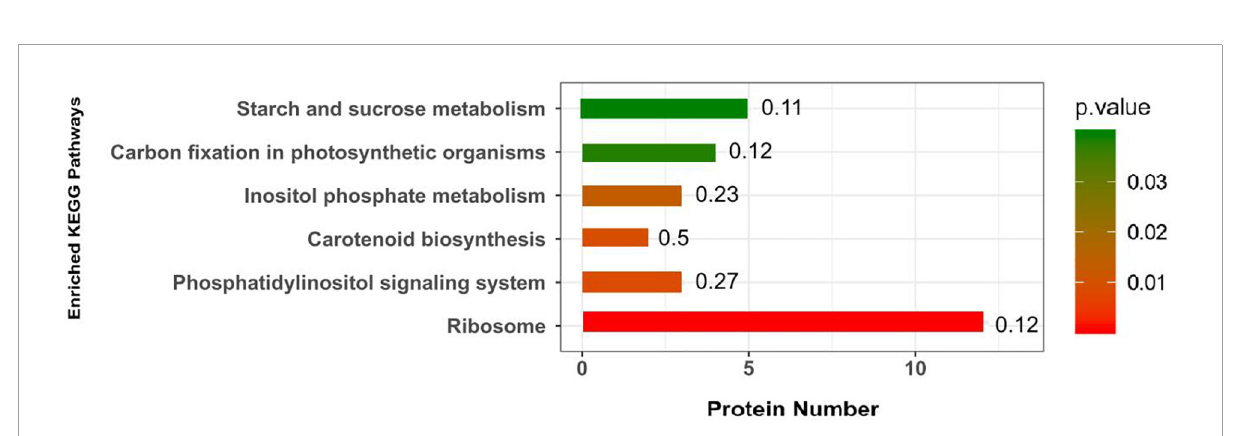
FIGURE2 Kyoto Encyclopedia of Genes and Genomes (KEGG) pathway of the DEPs in soybean roots. The abscissa represents -log 10 ( P- value) for each pathway.